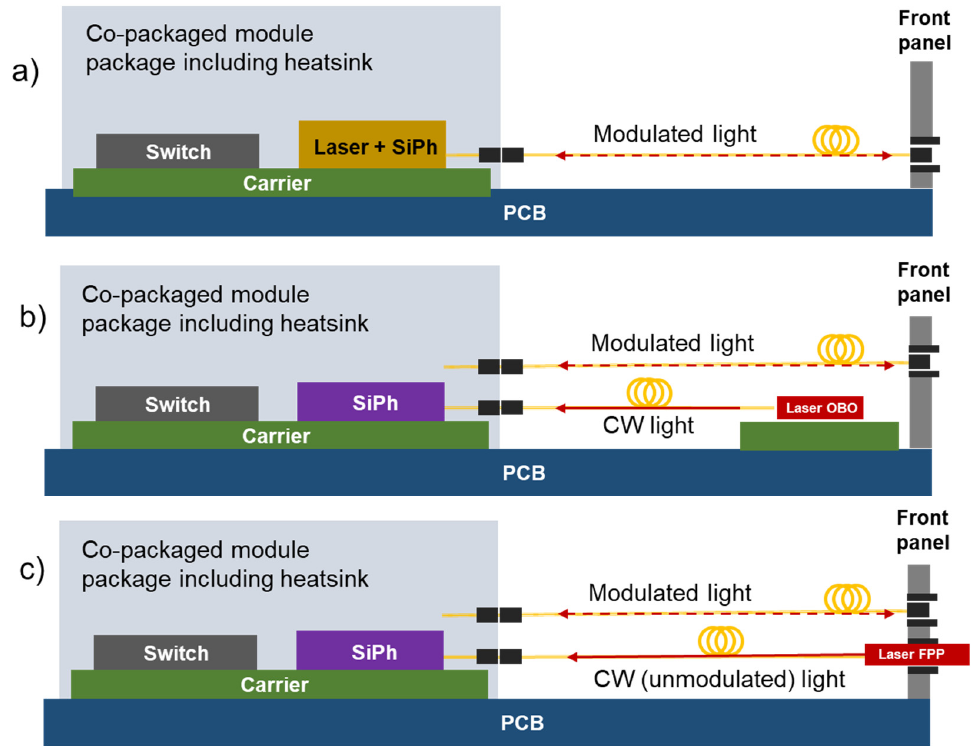
Figure 5. Silicon photonics chiplets in a co-packaged assembly with ( a ) integrated laser source, ( b ) external laser source mounted on the board and ( c ) front-pluggable and completely field-replaceable external light source on faceplate .